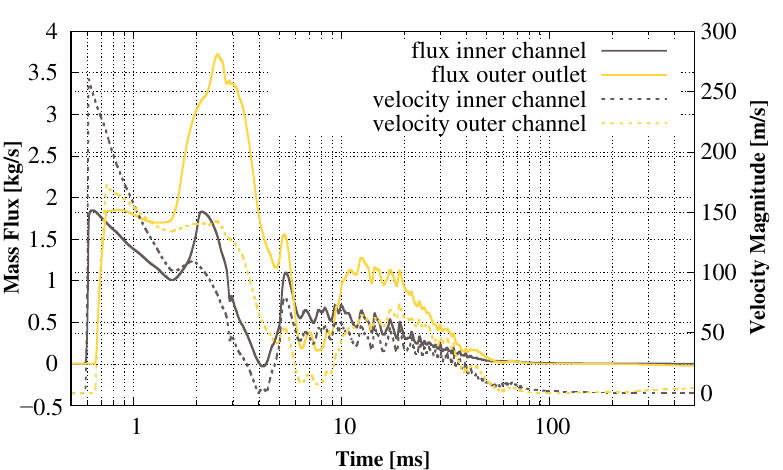
Figure 10. Mass flux and velocity magnitude distribution between considered outlet channels.